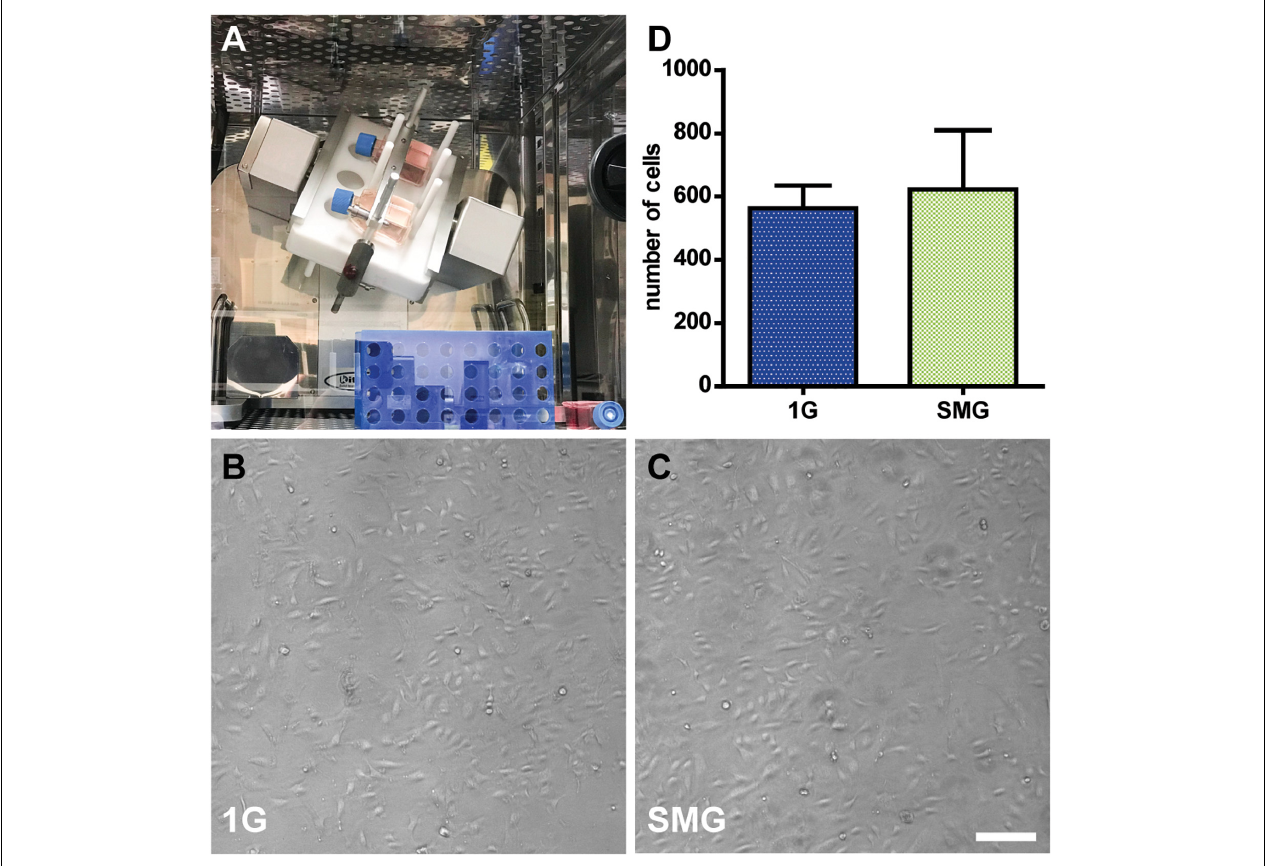
FIGURE 5 | The morphological analysis of human umbilical vein endothelial cells (HUVECs) under simulated microgravity. (A) The clinostat is installed in a CO 2 incubator. The 1G control flasks were placed next to the clinostat (bottom right). Phase-contrast images of HUVECs after 3 days of exposure to 1 G (B) and simulated microgravity (C) . Marker: 200 µ m. (D) The number of cells in the simulated microgravity conditions compared to those in the control condition after 7 days of culturing. For each condition n = 3. Data were expressed as the mean ± S.E.M.